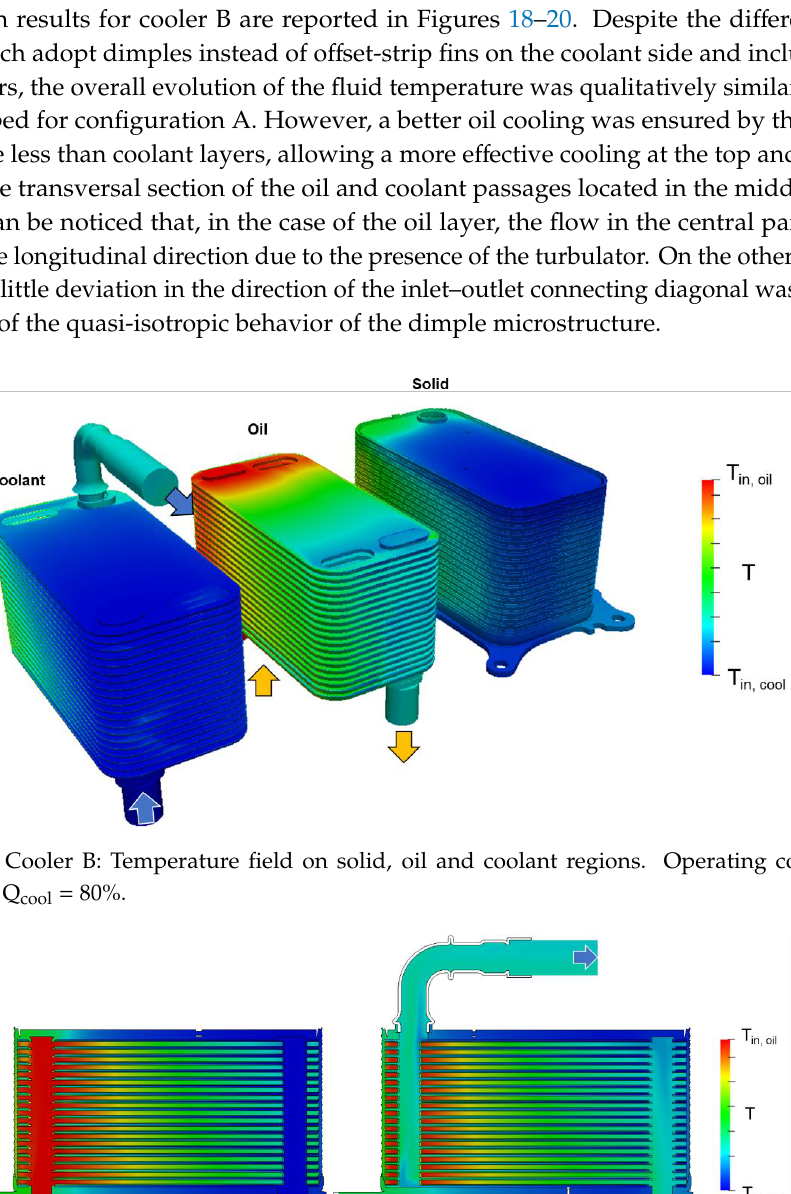
Figure 20. Cooler B: Temperature distribution across two transversal planes for oil and coolant passages, located in the middle of the heat exchanger. Flow direction is also reported. Operating conditions: Q oil = 50%, Q cool = 80%. Figure 21 reports the pressure drops computed for the coolant side of the two configurations, along with the corresponding measured values. The pressure drop was evaluated, both in the experiments and in the simulations, at the inlet and outlet sections of the cooler, including therefore also the effect of the connecting bended pipes (Figure 6). It is worth highlighting that configuration A is equipped with offset-strip fins turbulator while configuration B includes dimple-type turbulator. The agreement between simulations and measurements could be judged as satisfactory, since the maximum error was below 5% (computed with respect to the maximum value of the dataset). Despite the different turbulator type, the pressure drops of configurations A and B were similar: This was due to the fact that the higher number of layers of configuration B compensates the higher Fanning factor of the dimples with respect to the offset-strip fins. (a) (b) Figure 21. Pressure drop on coolant side: ( a ) Cooler A, with offset-strip fins turbulator and ( b ) cooler B, with dimple-type turbulator. Results are normalized with respect to the maximum value of the dataset (cooler B, oil side, Q oil = 100%).